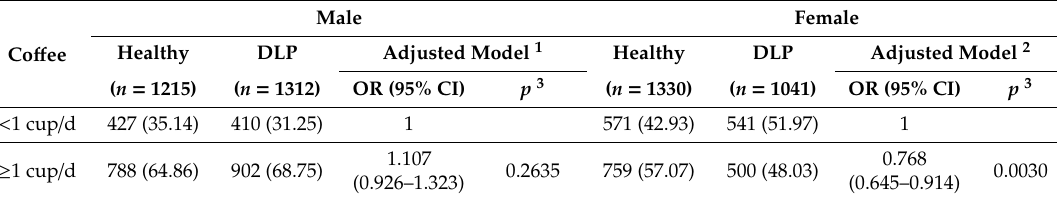
Table 3. Associations between co ff ee intake and the risk of dyslipidemia.